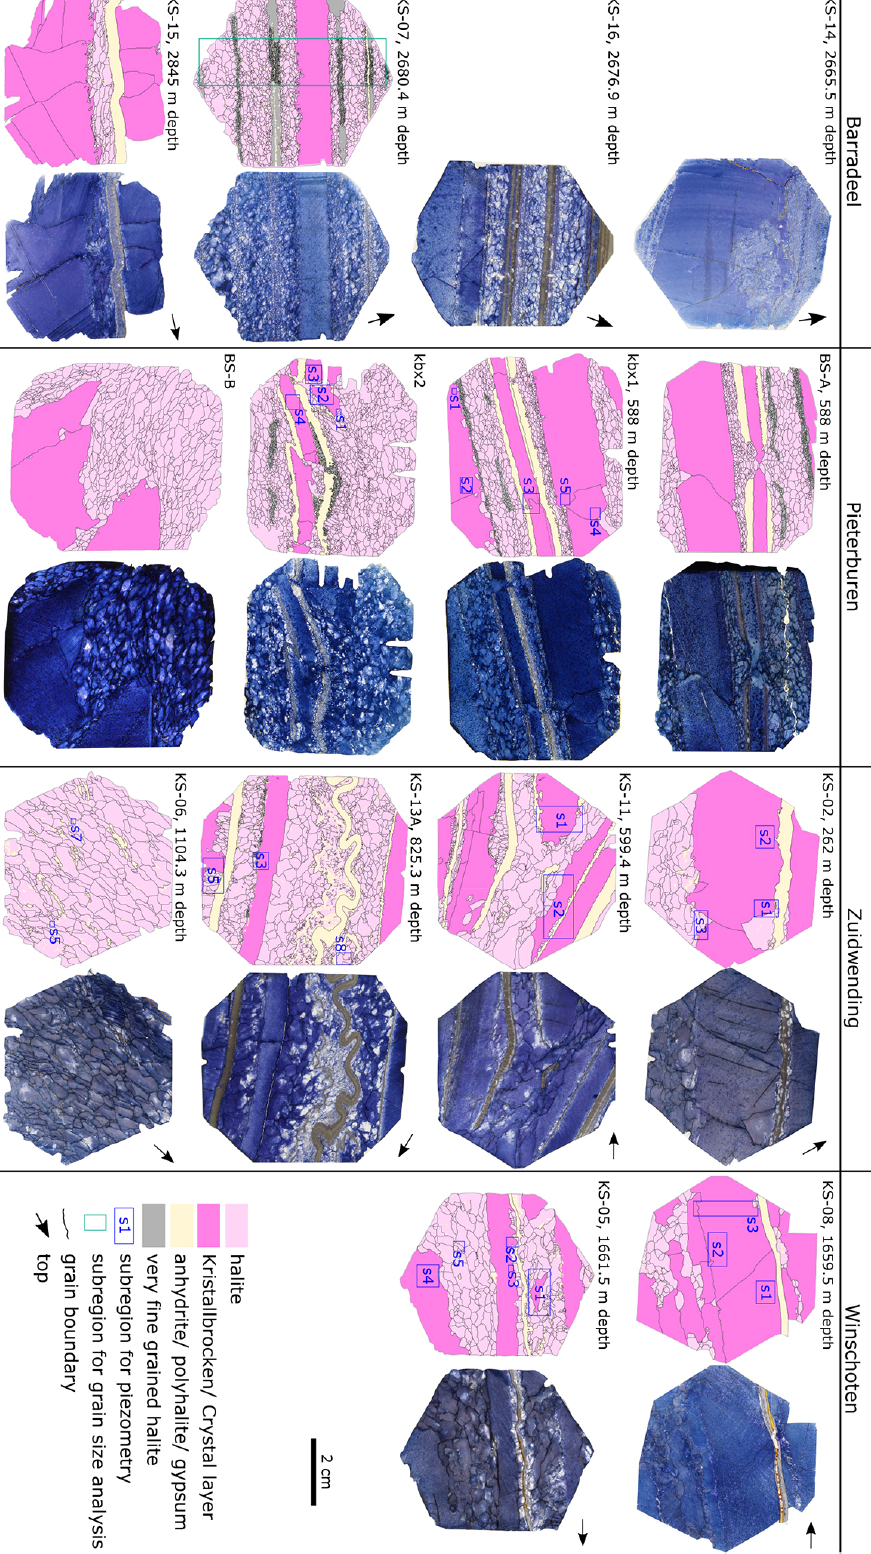
Figure 3. Overview of gamma-decorated samples from Barradeel, Pieterburen, Zuidwending, and Winschoten, together with maps of the interpreted microstructures. Reflected-light images that were used for interpretation of grain boundaries are presented in supplement 2 in Barabasch et al. (2022). Anhydrite, polyhalite, and gypsum layers were all mapped, but dispersed particles were mapped only partly as